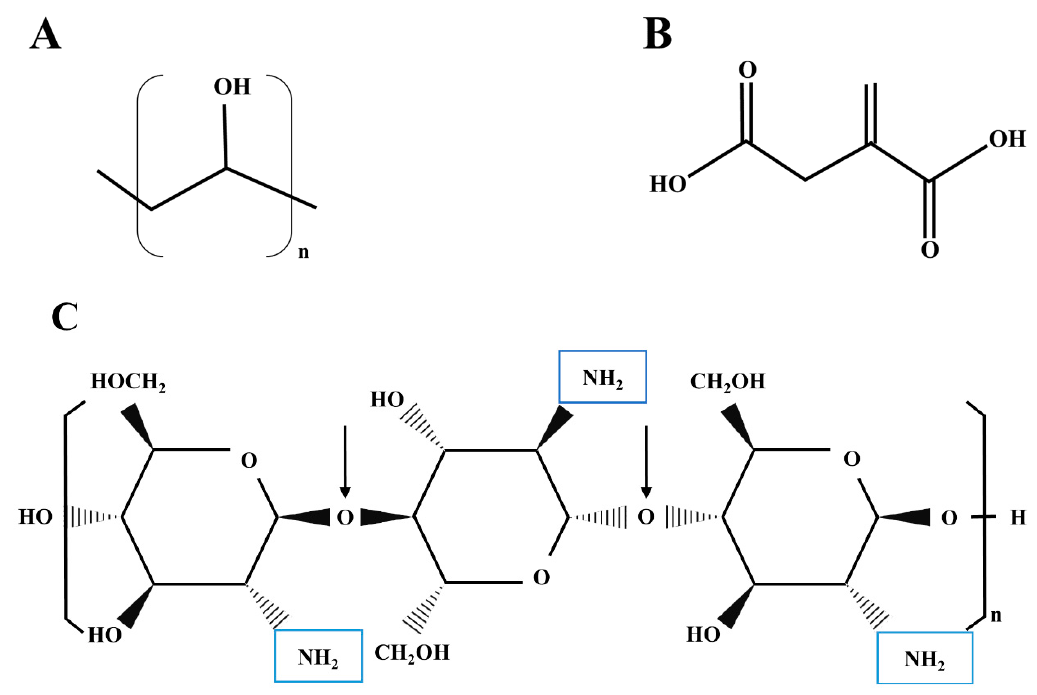
Figure 1. Chemical structures of poly(vinyl alcohol) (PVA) ( A ), itaconic acid ( B ), and chitosan ( C